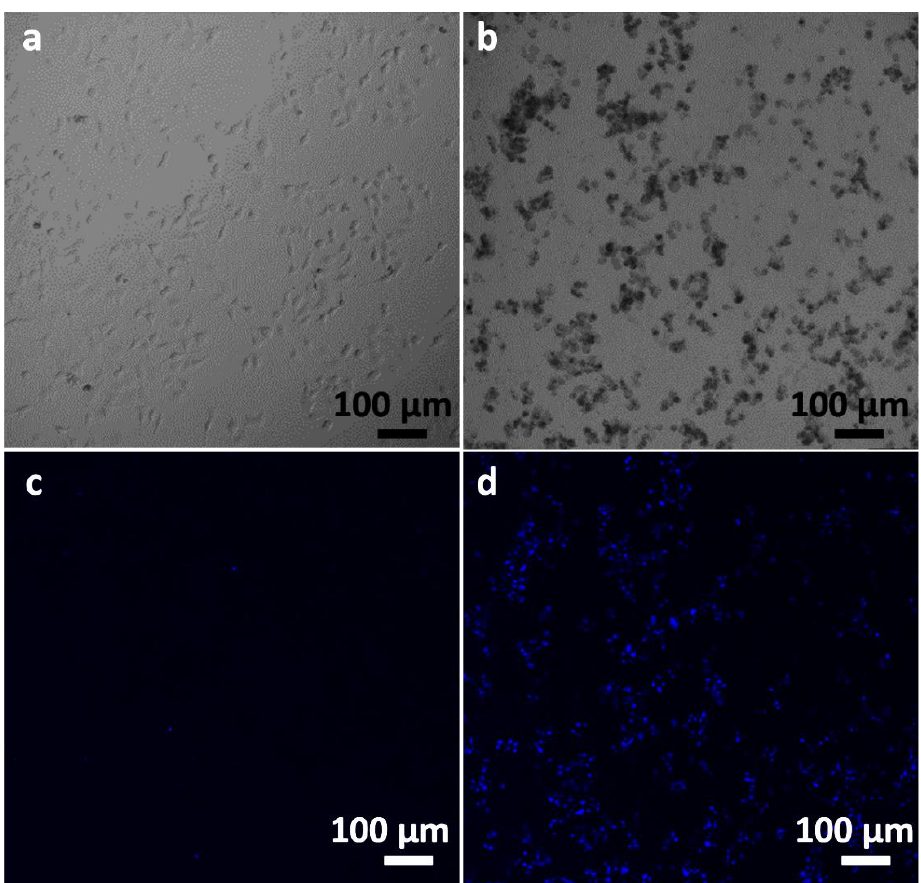
Figure 8. Bright-field optical and fluorescent microscopy images of MSNs@SPIONs@PDA internal- ized in HeLa cells by: ( a , c ) passive uptake and ( b , d ) magnetic uptake.